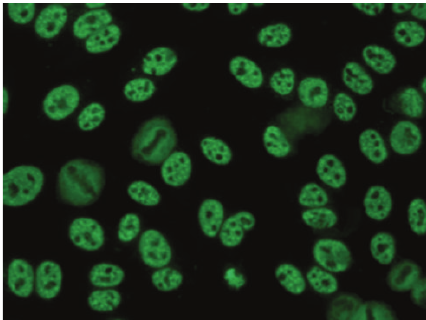
Figure 3: IIF on Hep2 cells: speckled pattern (anti-RNP antibodies). Dilution